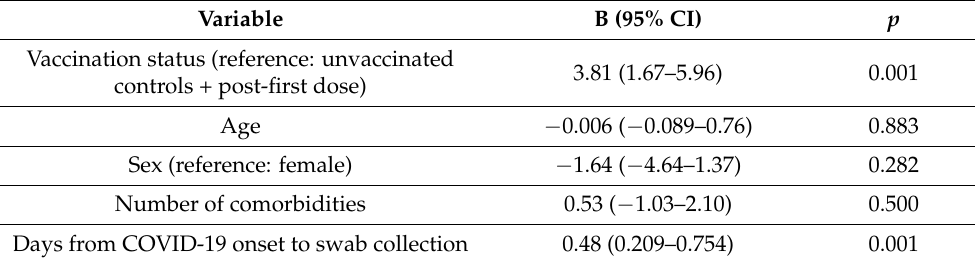
Table 2. Linear regression model for the association of SARS-CoV-2 PCR cycle threshold values at diagnosis and vaccination status among symptomatic infections ( n =